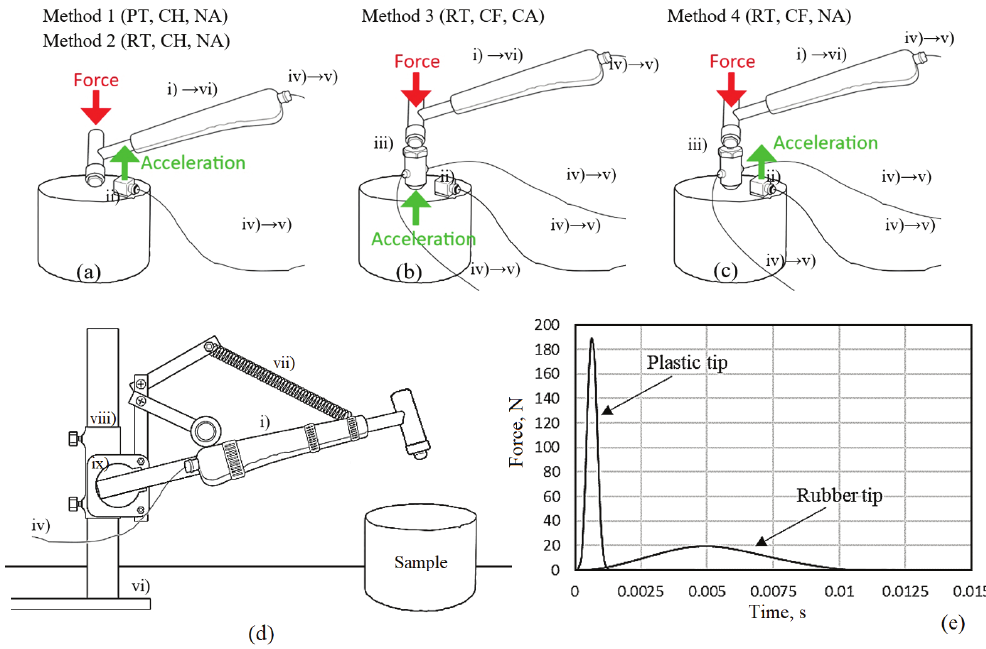
Figure 5. Test set up. (a) Method 1 / Method 2, (b) Method 3, (c) Method 4, (d) device to control the reference height of the hammer, (e) impulse shape of force as function of the hammer